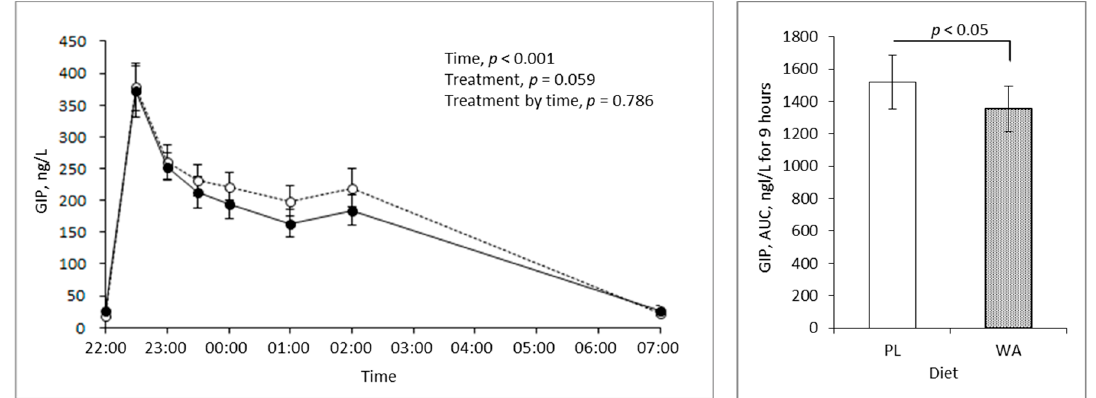
Figure 4. Changes in the blood glucose-dependent insulinotropic polypeptide (GIP) level during the night between the PL (broken line, n = 20) and WA treatments (solid line, n = 20). ( Left ) Changes in the blood GIP response. ( Right ) The AUC of the blood GIP level for 9 hours from 22:00 hour to 7:00 hour. Data are the mean ± standard error.